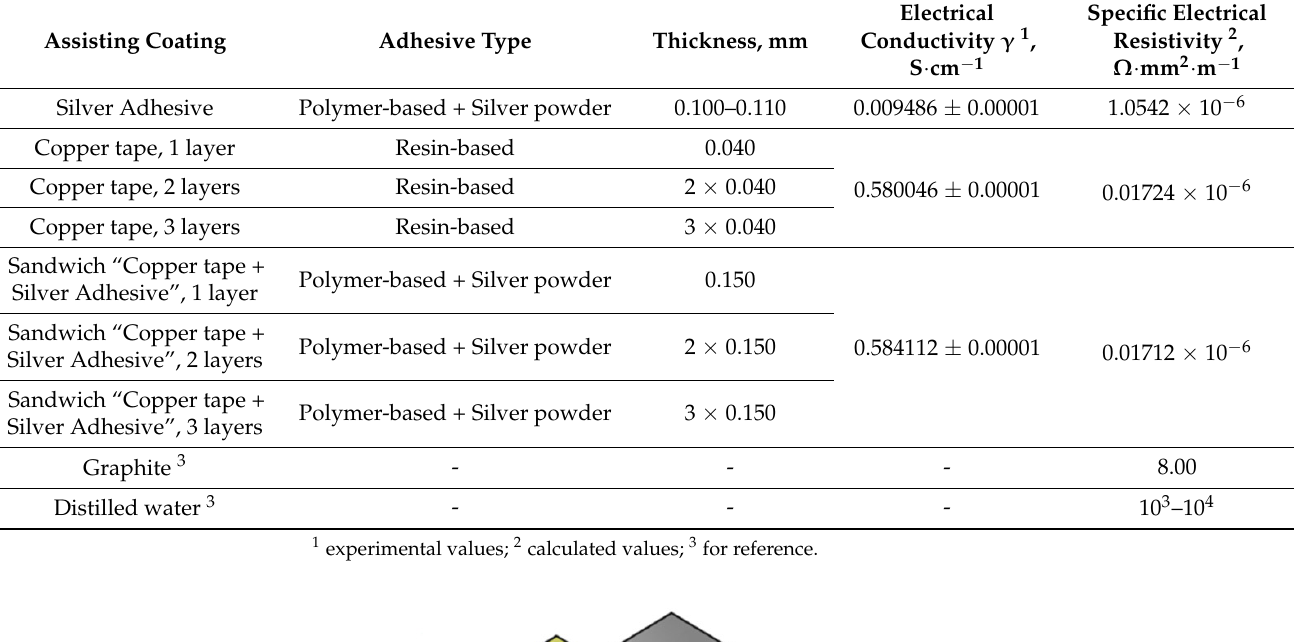
Table 4. Developed assisting coatings.